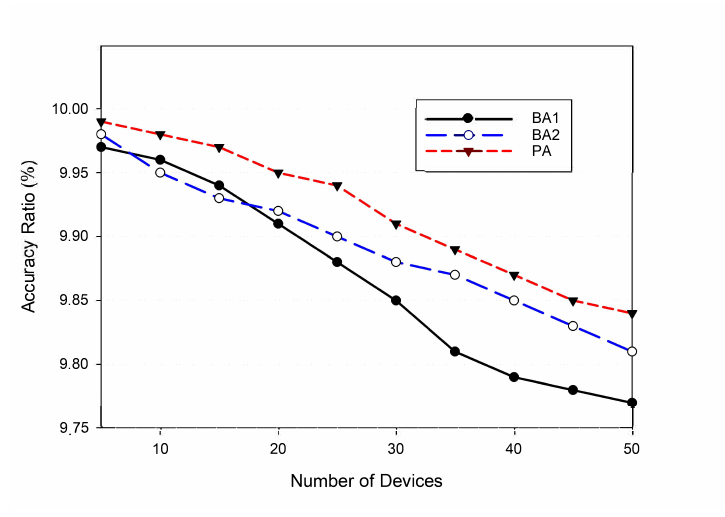
Figure 5. Proposed approach’s accuracy compared to the baseline approaches.